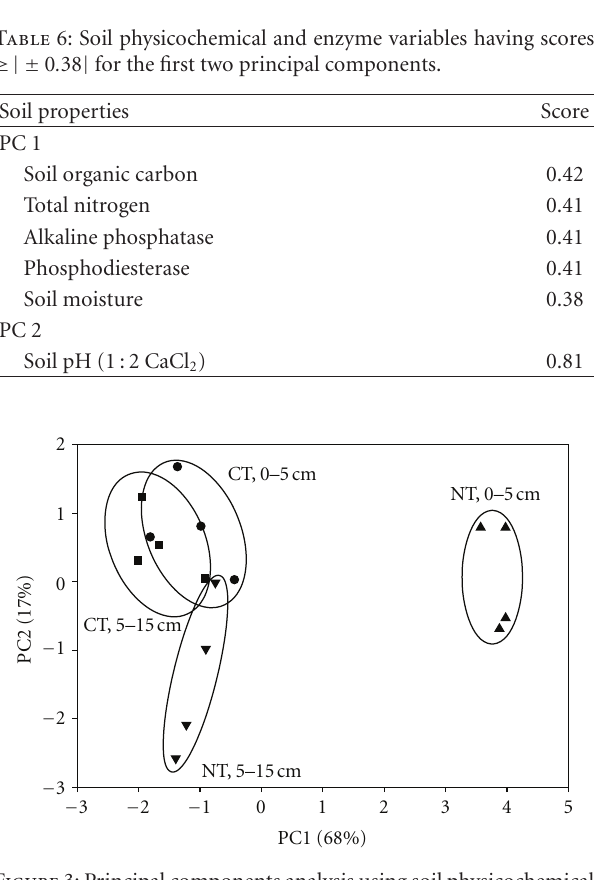
Figure 3: Principal components analysis using soil physicochemical and enzyme